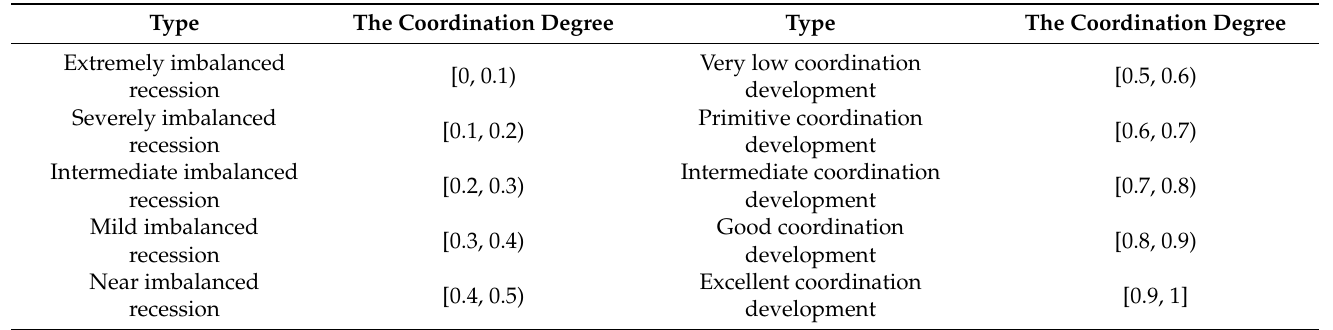
Table 3. The classification of the coordination